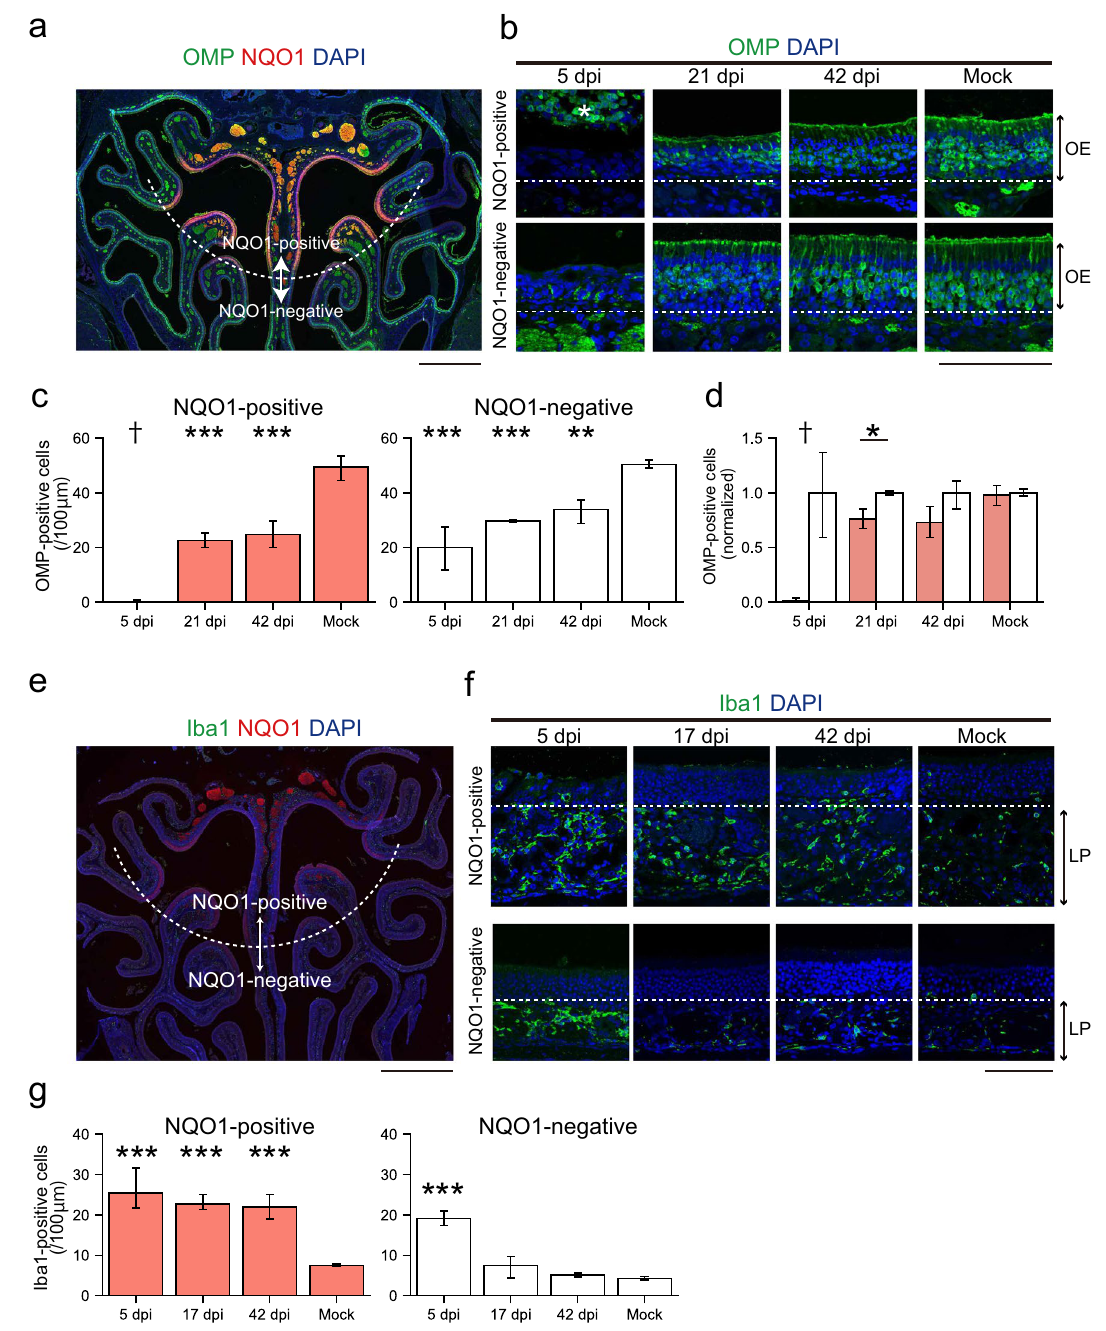
Figure 4. Region-specific damage of the olfactory epithelium (OE) due to SARS-CoV-2 infection. (a) Representative coronal section of the OE stained with olfactory marker protein (OMP), NAD(P)H quinone oxido-reductase 1 (NQO1), and DAPI. The white dashed line is the border of the NQO1-positive or -negative region. Scale bar, 1 mm. (b) Representative images of OMP-positive cells at 5, 21, and 42 dpi or mock in the OE. The white dashed line is the border between the OE and lamina propria. The asterisk indicates desquamated epithelium. Scale bar, 100 μm. (c) Numbers of OMP-positive cells in the NQO1-positive or -negative region (one-way ANOVA followed by Dunnett’s post hoc test. **p < 0.01, ***p < 0.001, † means unevaluable as the OE was completely desquamated and OMP-positive cells were not countable). Number of samples: n = 3 (5, 21 and 42 dpi) and 4 (mock). (d) Comparison of the normalized density of OMP-positive cells in NQO1-positive and NQO1-negative regions. (n = 3, Welch’s t-test. *p < 0.05, † means unevaluable as the OE was completely desquamated and OMP-positive cells were not countable). (e) Representative coronal section of the OE stained with ionized calcium binding adaptor molecule 1 (Iba1), NQO1, and DAPI. The white dashed line is the border of the NQO1-positive or -negative region. Scale bar, 1 mm. (f) Representative images of Iba1-positive cells at 5, 17, and 42 dpi or mock. The white dashed line is the border between the OE and lamina propria. Lamina propria, LP. Scale bar, 100 μm. (g) Densities of Iba1-positive cells in the NQO1-positive or -negative region (one-way ANOVA followed by Dunnett’s post hoc test. ***p < 0.001). Number of samples: n = 3 (5, 17 and 42 dpi) and 4